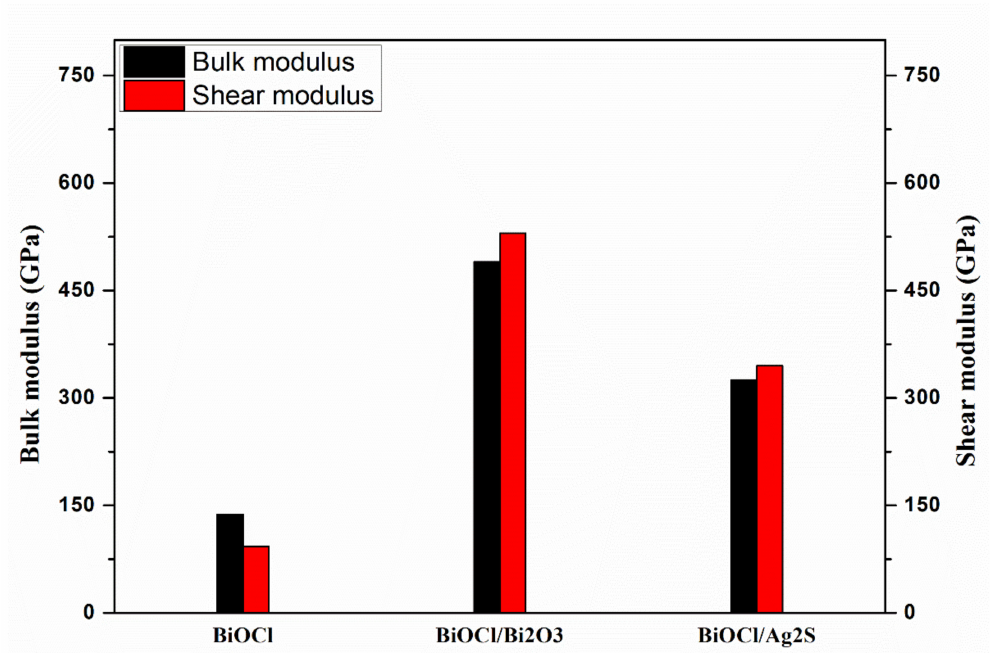
Figure 5. Bulk and shear modulus of BiOCl, Bi 2 O 3 /BiOCl, and BiOCl/Ag 2 S in three directions (x, y, and